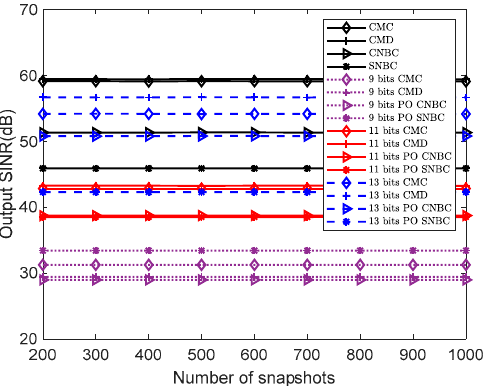
Figure 14. The output SINR versus the number of snapshots on different quantization bits.